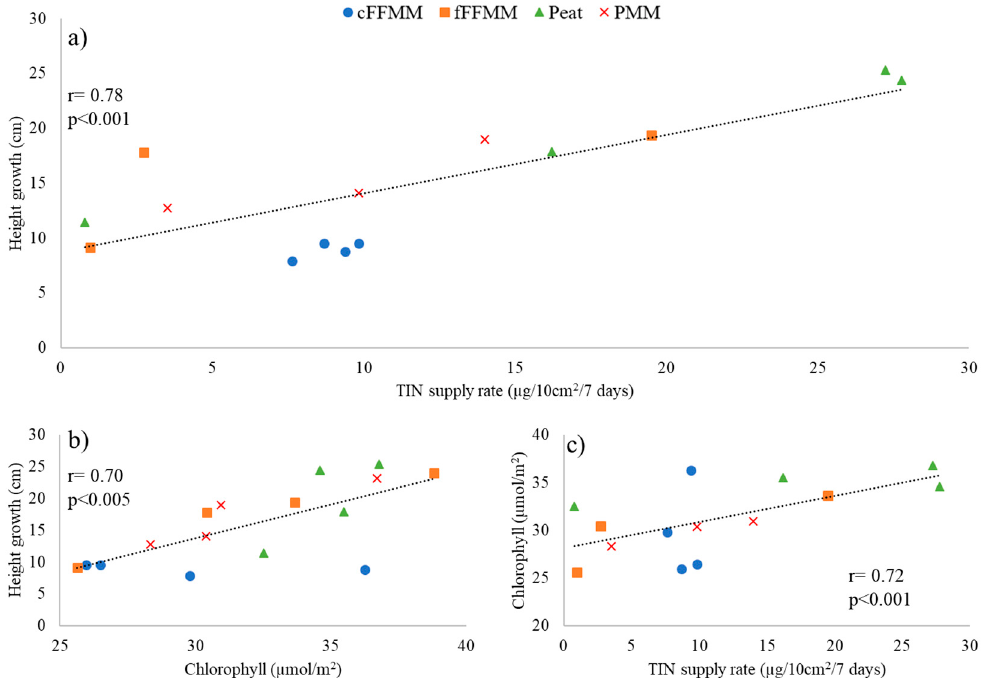
Figure 4. Scatter plots between height growth and total inorganic nitrogen (TIN) supply rates ( a ) (r = 0.77, p < 0.001), height growth and chlorophyll concentration ( b ) (r = 0.70, p = 0.004), and chlorophyll concentration and TIN supply rates ( c ) (r = 0.72, p < 0.001) among the different soil types. cFFMM (blue dot), fFFMM (orange square), peat (green triangle) and PMM (red cross). Each data point represents an average of each treatment.